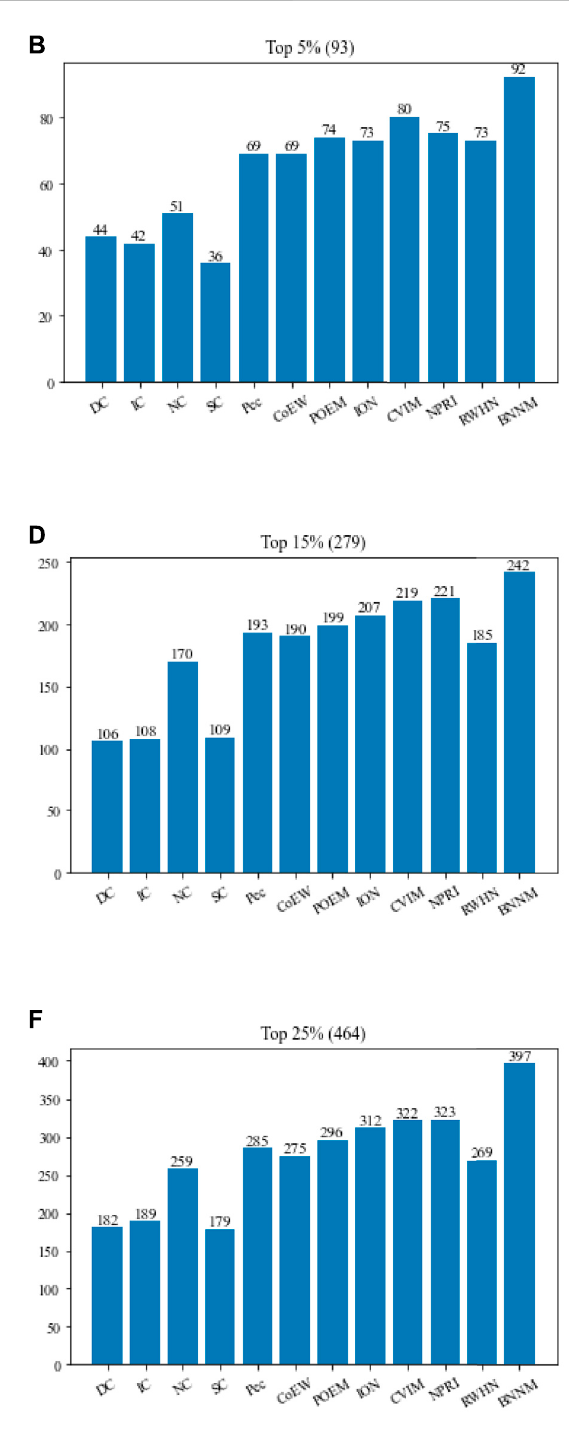
FIGURE 5 Performance comparison between TNNM and 11 competitive algorithms based on the Gavin database. (A) The number of essential proteins in the top 1% candidate proteins. (B) The number of essential proteins in the top 5% candidate proteins. (C) The number of essential proteins in the top 10% candidate proteins. (D) The number of essential proteins in the top 15% candidate proteins. (E) The number of essential proteins in the top 20% candidate proteins. (F) The number of essential proteins in the top 25% candidate proteins. In above fi gures, the number in parentheses represents the number of proteins in each